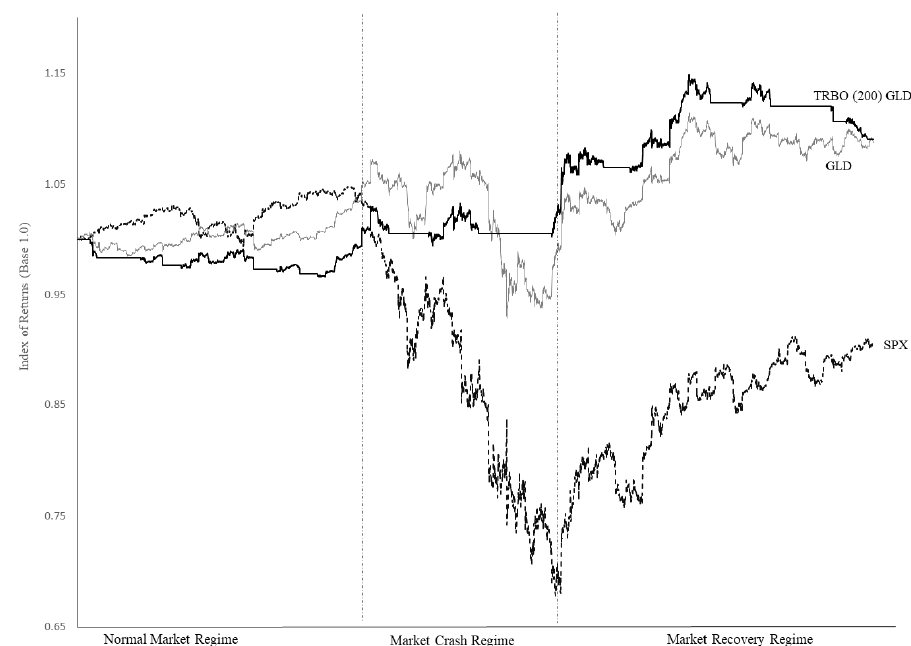
Figure 2. SPX, GLD, and TR pathways. Figure 2 presents the paths taken by the SPX, GLD, and the TRBO (200) trading rule (after taxes) in the GLD market across the entire period analyzed and three market regimes (i.e., Normal Market Regime, Market Crash Regime, and Market Recovery Regime). The x-axis presents the period of 6 January 2020 (i.e., the first day the TRBO (200) generated a trading signal) to 12 May 2020. The y-axis presents the index of returns with a base of 1.0 at the start of 6